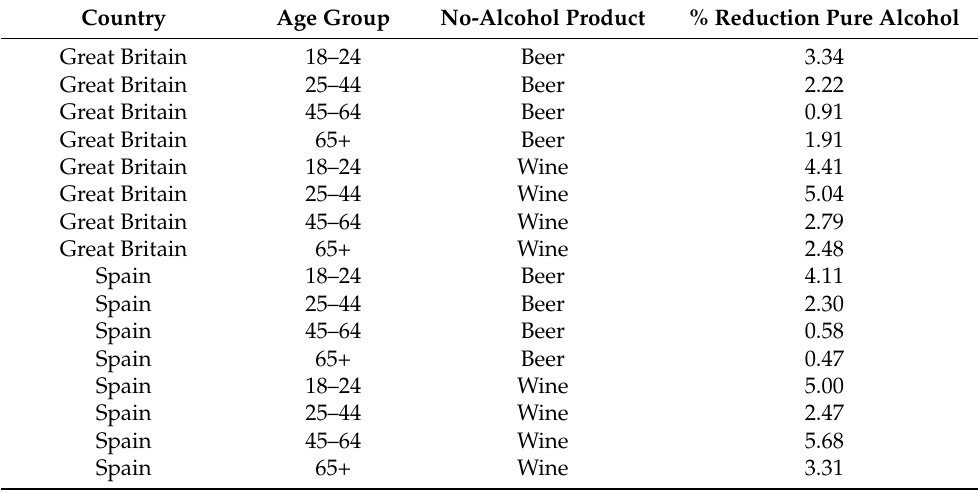
Table A3. Associated reductions or pure alcohol by age of the main household